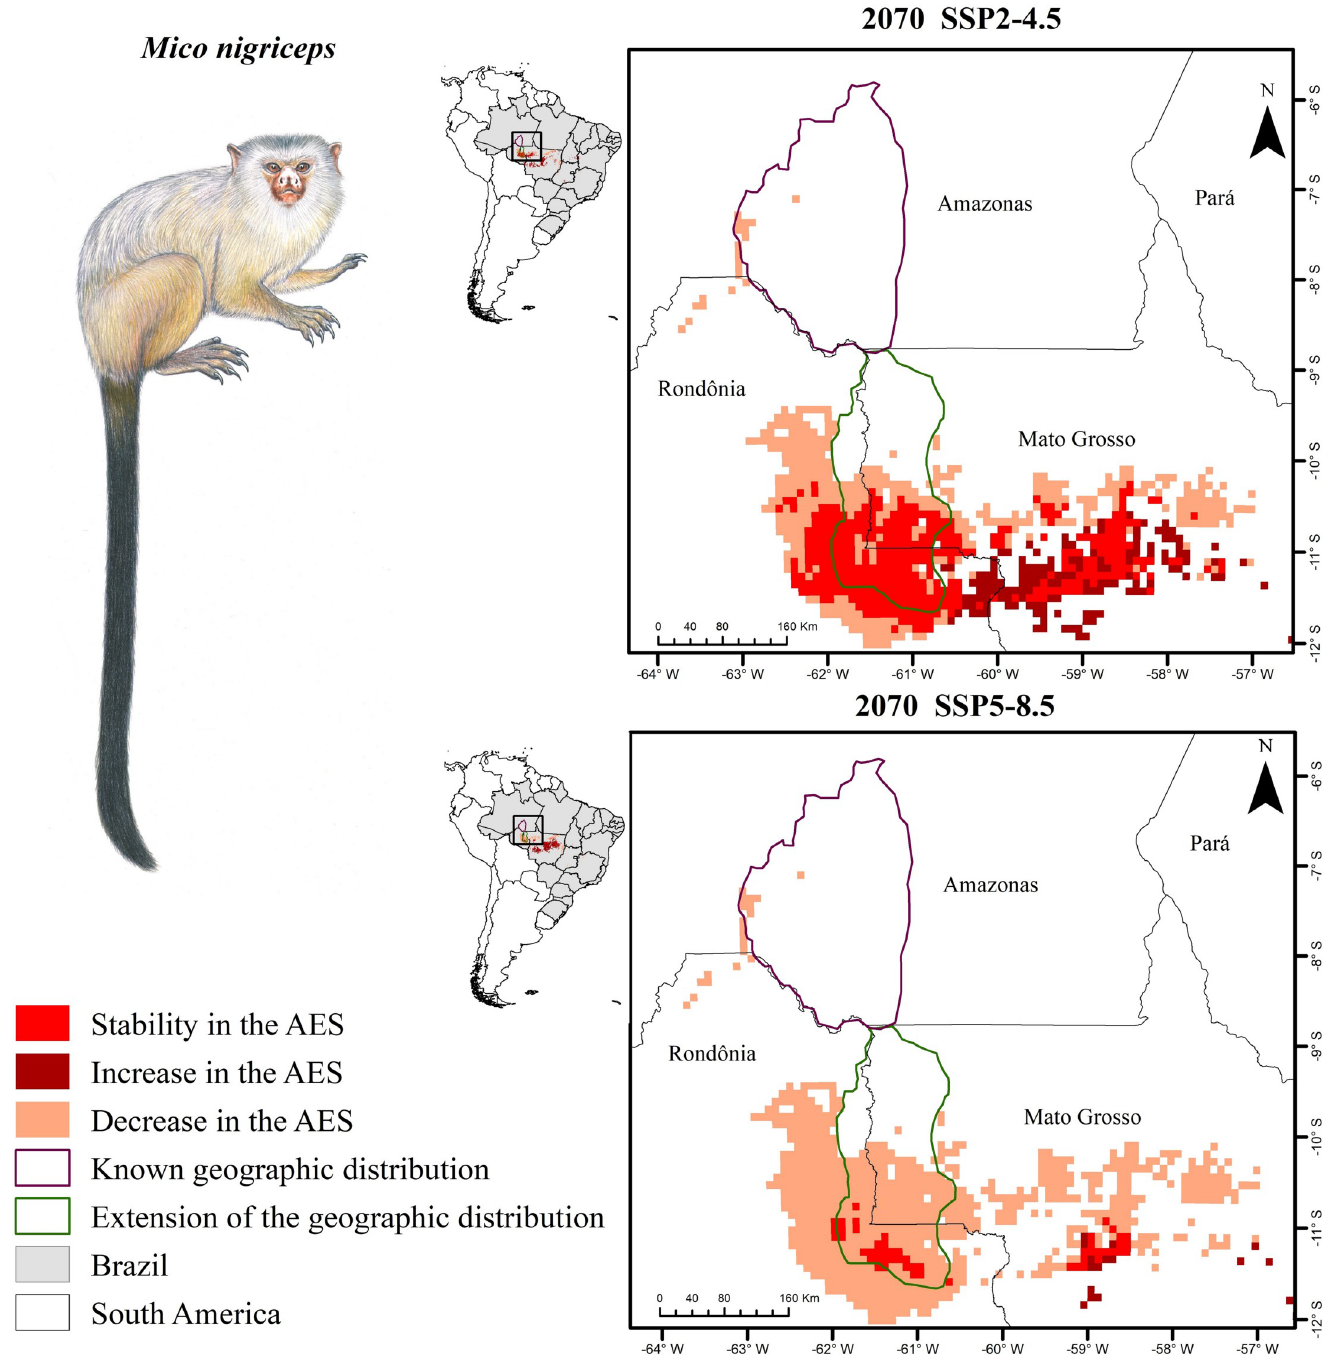
Fig 3. Modeling-generated map. Modeling-generated map of current and future distributions for M . nigriceps . Mico nigriceps illustration reprinted from Ferrari and Lopes (1992) under a CC BY license, with permission from Stephen D. Nash, original copyright 2021. Shapefiles by: Ministe´rio de Meio Ambiente. AES Area.